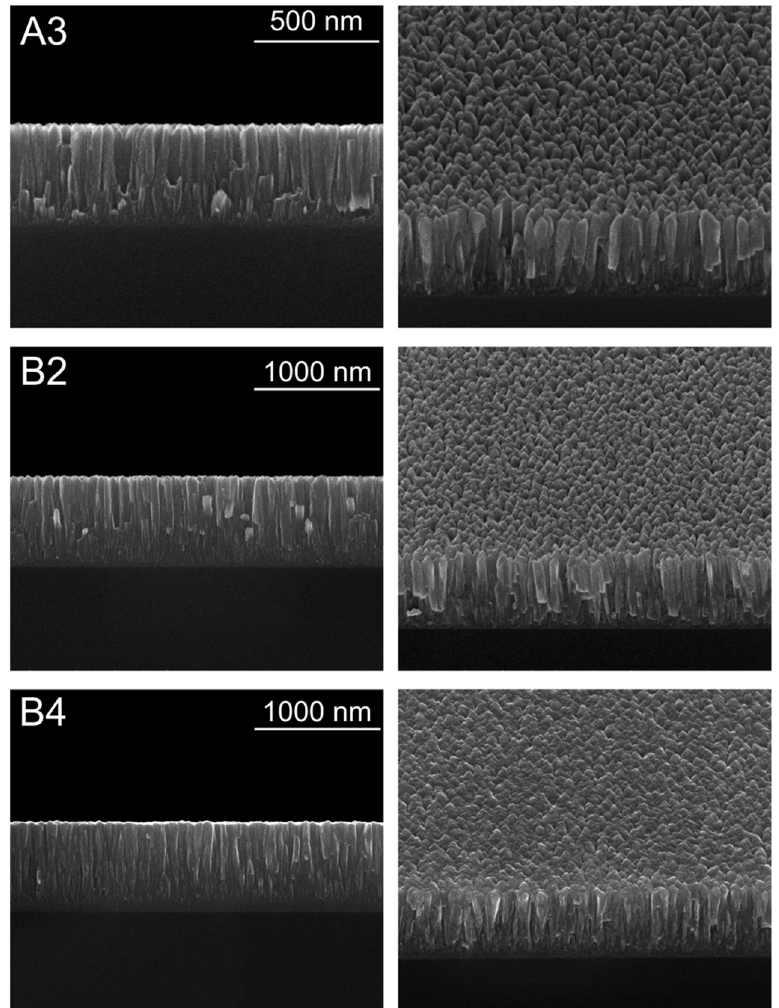
Figure 3. Representative SEM images for the set of studied samples. In particular, the left column shows the cross-section and the right column the top view for the A3, B2, and B4 studies films. The scale bar indicated for the cross-section images is the same for the top-view ones.